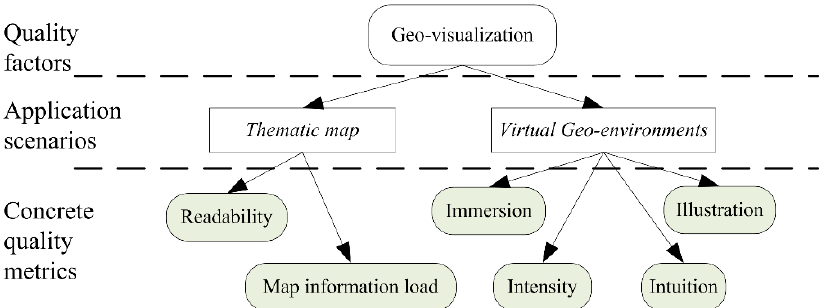
Figure 4. The geo-visualization quality in different application scenarios.